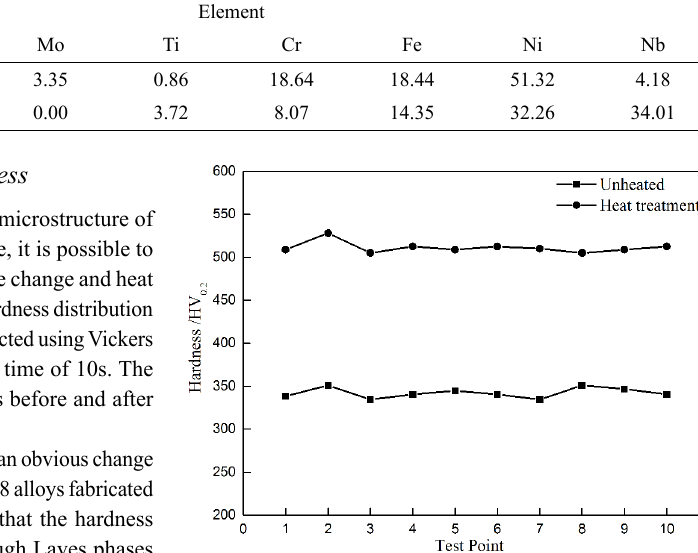
Figure 4. The curve of hardness distribution in the Z-Y surface of alloys before and after heat treatment.